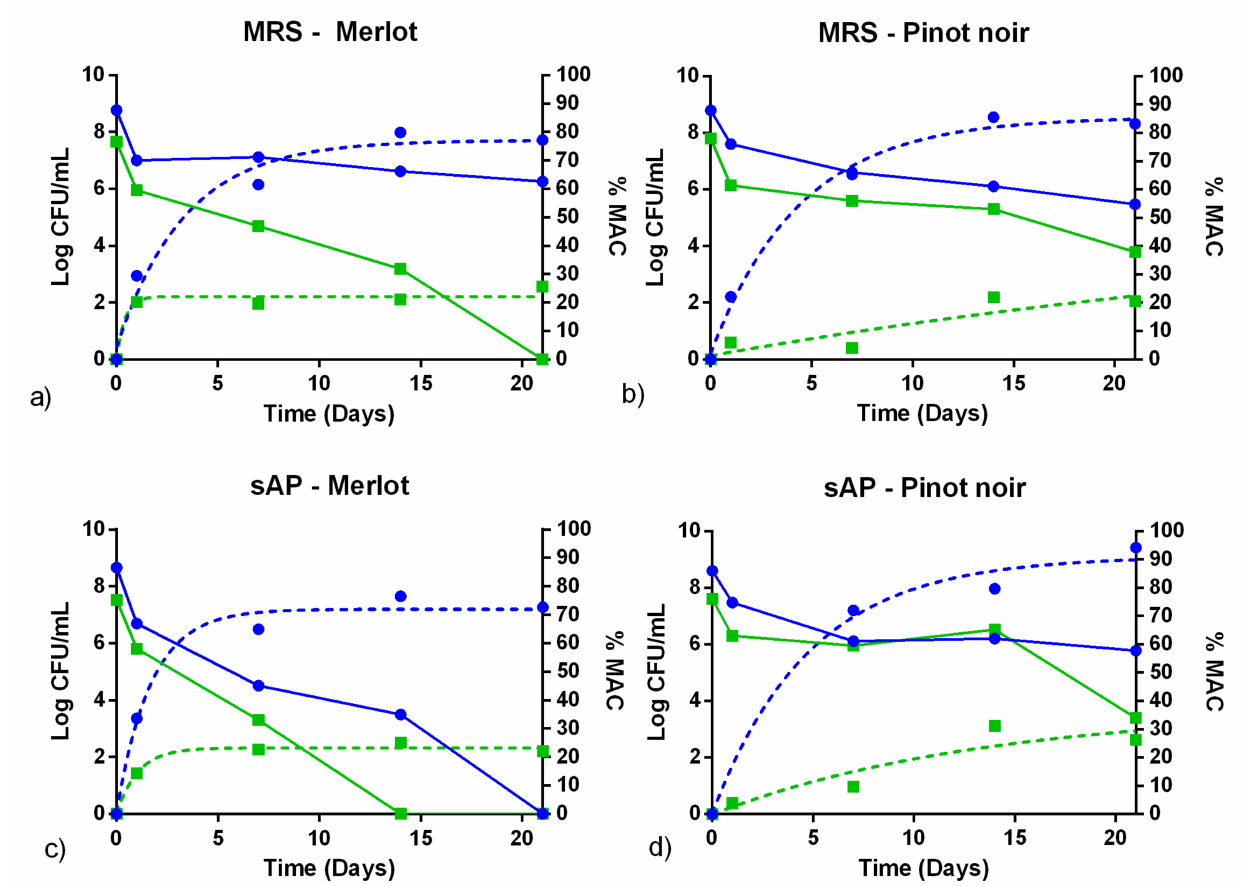
Figure 4. Fermentation assays in sterile Merlot (left column) and Pinot noir (right column) wines, of UNQLp 11 cultures growing in MRS pH 6.2 ( a , b ) or in sAP medium (supplemented with yeast extract, salts, and Tween) pH 6.2 ( c , d ). The full lines show the count of viables (LogCFU/mL) and the dotted lines the percentage of L-malic acid consumed (% MAC ), obtained according to a non-linear regression of exponential decay. High size inoculums are displayed in blue and low inoculums in